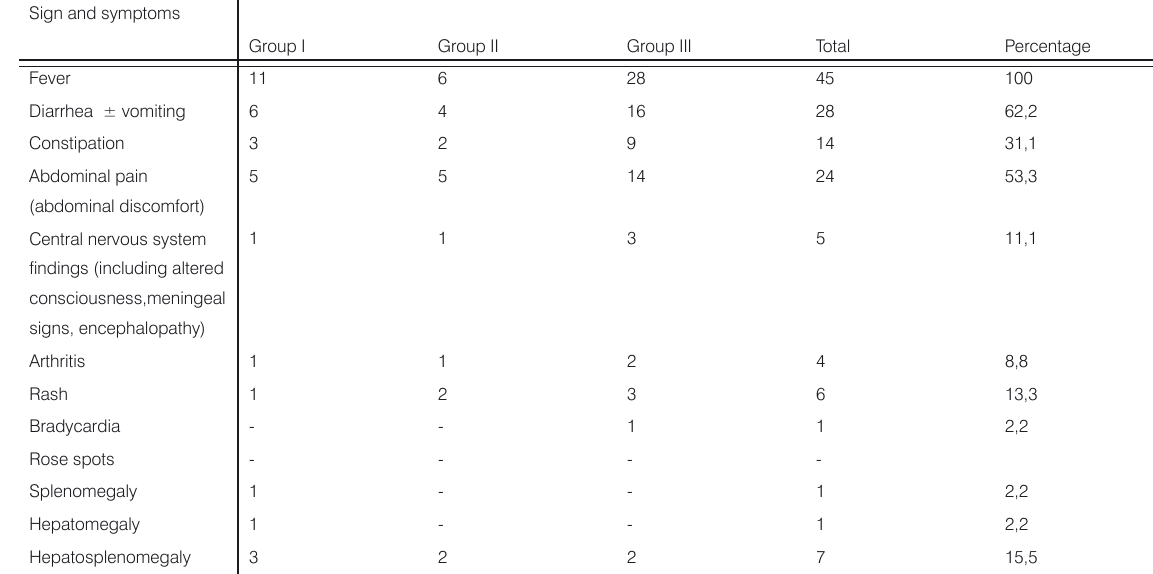
Table 1. Signs and symptoms of cases in groups I, II and